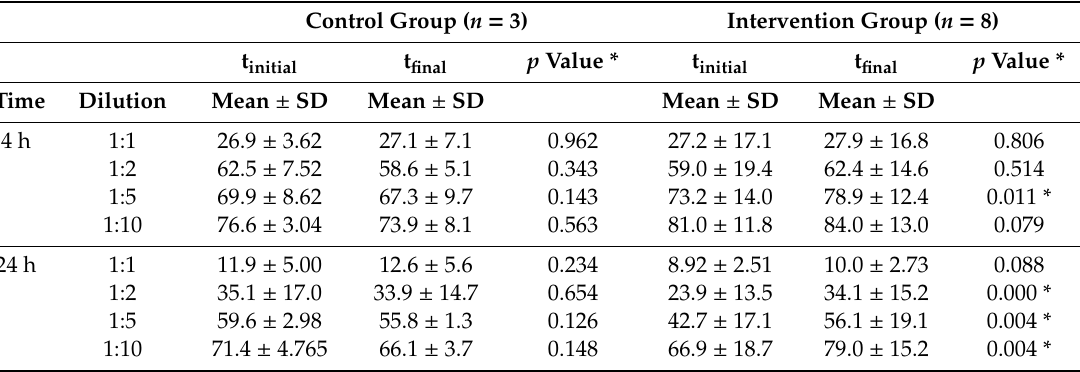
Table 3. Viability (% with respect to the control) of HCT 116 cells after exposure to FW from the control and intervention groups before (t initial ) and after (t final ) wine consumption. Data represent the mean and standard deviation (SD) of three independent experiments, each analysed in triplicate.